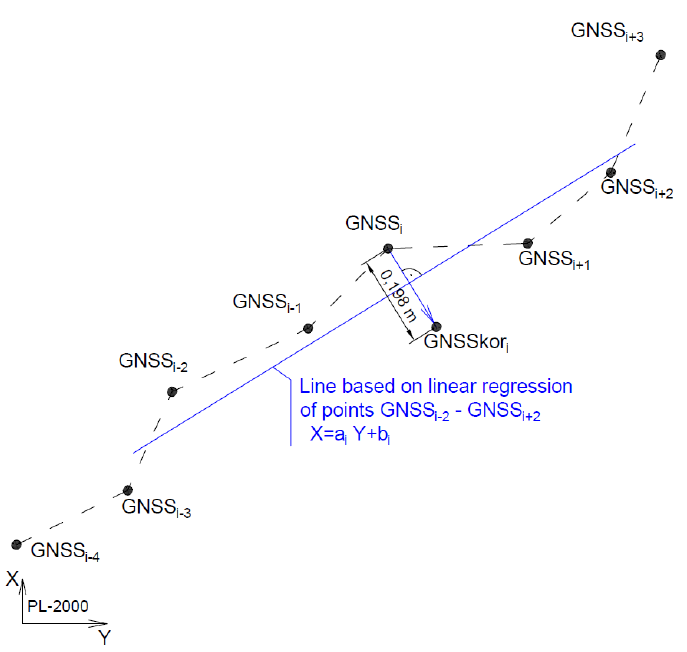
Figure 9. Schematic diagram of the coordinate adjustments.